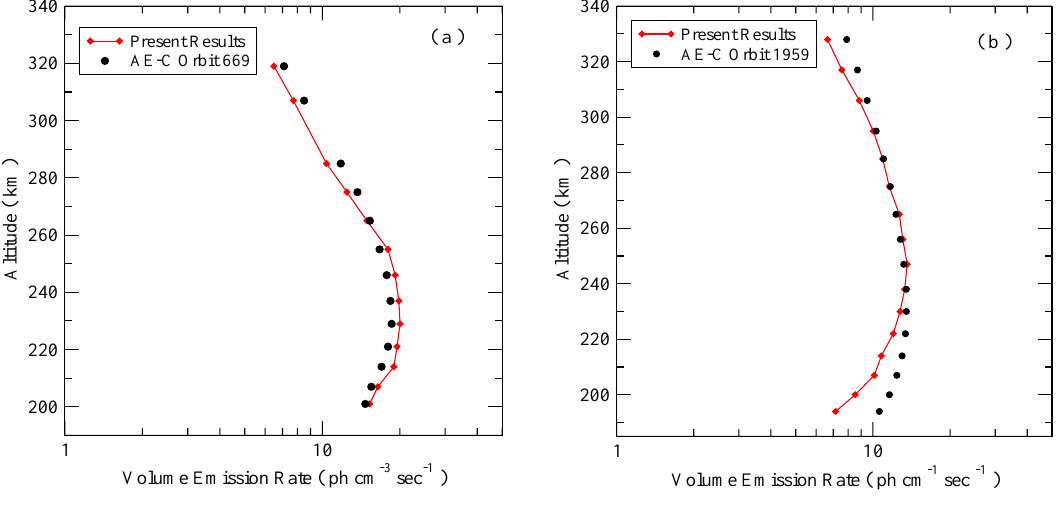
Fig. 1. Comparison of modeled Volume Emission Rates with the AE-C satellite data. AE-C orbit 669 upleg (a) and AE-C orbit 1959 (b) .